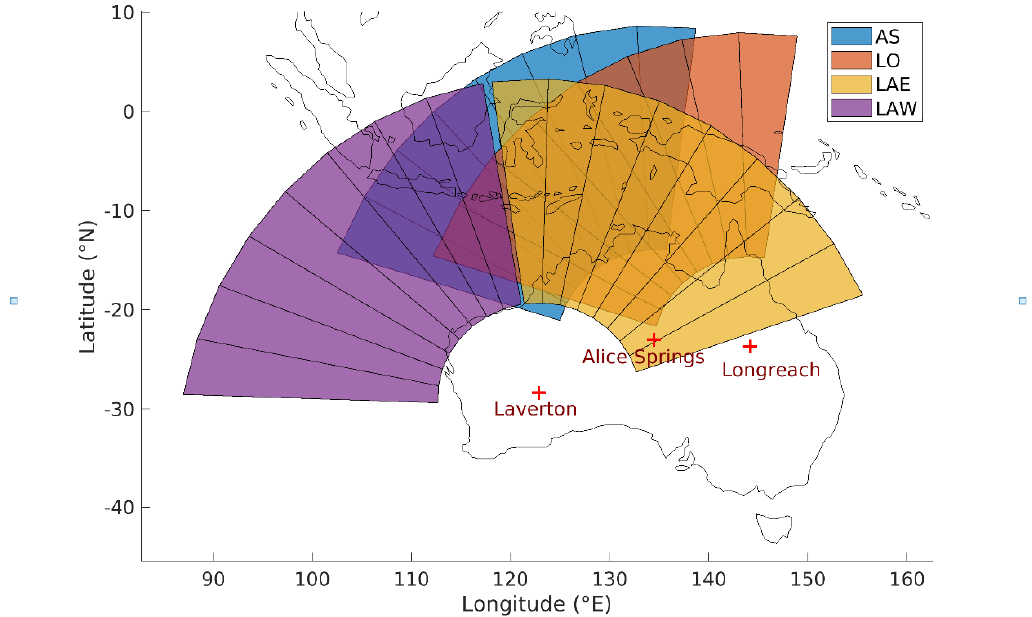
Figure 1. Fields of view of the four JORN FMS backscatter sounders. The inner and outer arcs are located at 1000 and 3500 km from the sounder.